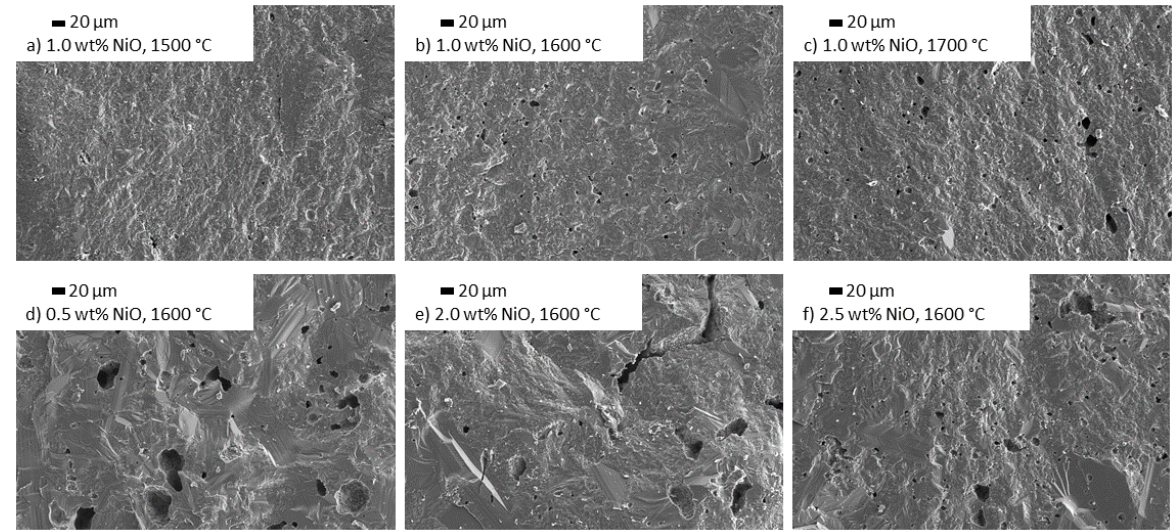
Figure 13. SEM images of Na- β″ -alumina samples sintered at 1500 °C, 1600 °C, or 1700 °C, doped with different amounts of NiO ( b – f ) in comparison to an undoped sample ( a ).